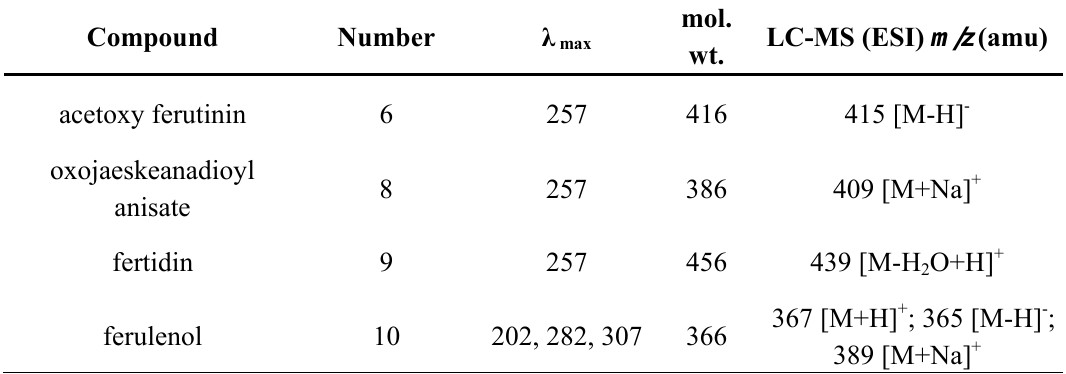
Table 4. Main signals exhibited in the HPLC-MS 2 spectra of compounds detected in F. communis extracts and UV Maxima ( λ proposed attributions.